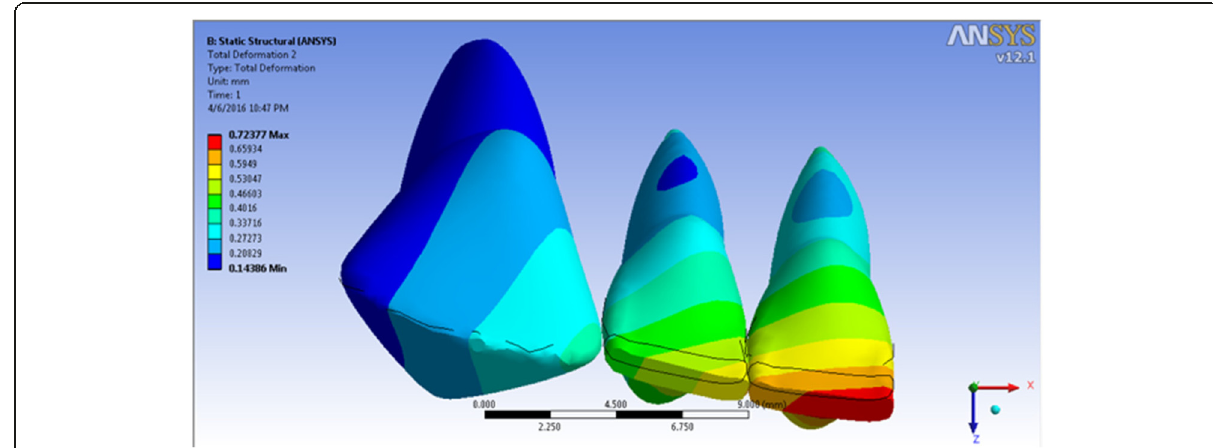
Fig. 8 Total deformation in the teeth of the fourth model (the inclination of the anterior teeth at 110° to the horizontal plane)